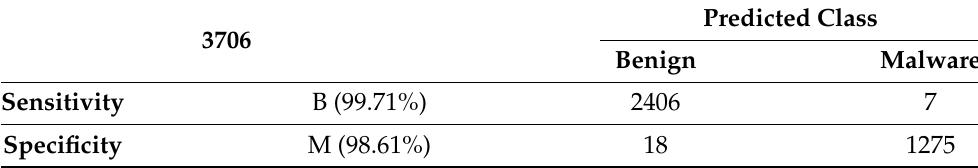
Table 5. DL Confusion matrix.